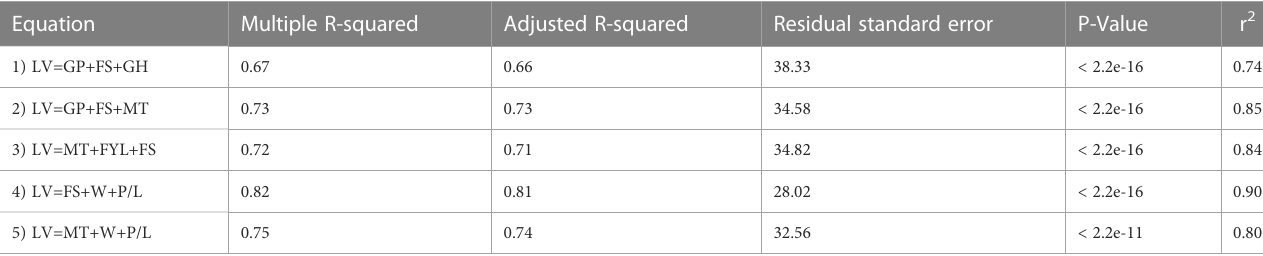
TABLE 2 Prediction equations for loaf